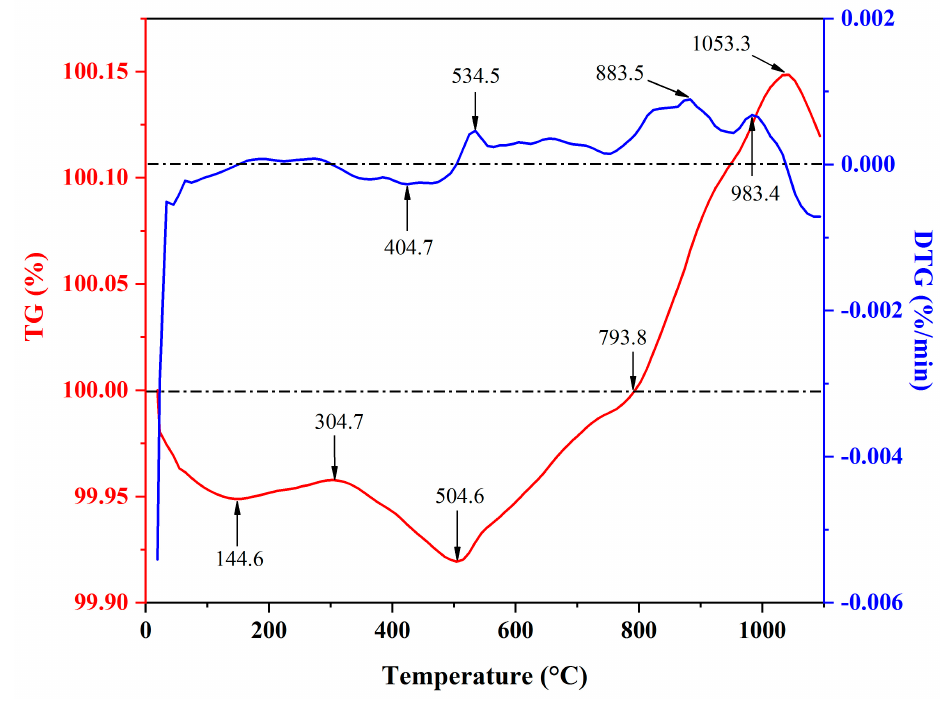
Figure 7. TG-DTG graph of ceramsite.